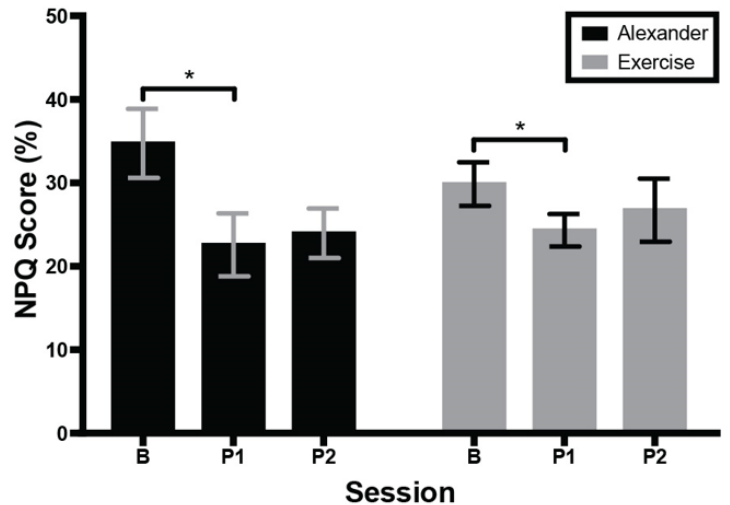
Figure 3. Score on Northwick Park Questionnaire (NPQ) across groups and testing sessions. Higher score indicates more neck pain and associated disability. Error bars are the standard error of the mean. B = baseline; P1 = 1st post-test; P2 = 2nd post-test. * indicates significant difference ( p < 0.05) between baseline and first post-test.